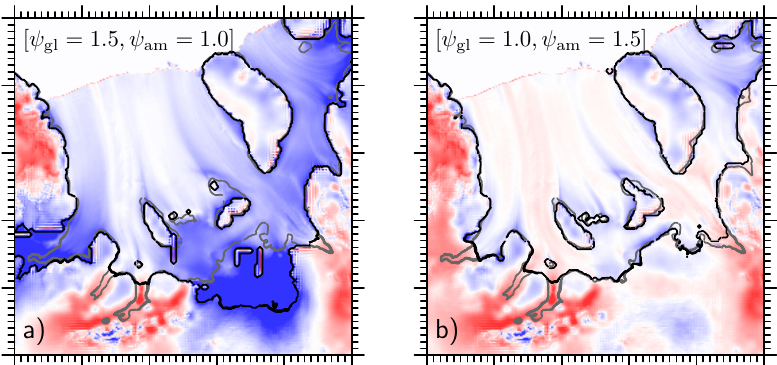
Figure 9. Grounding line location and ice thickness change over 2000-year model runs with enhanced sub-shelf accumulation/melt only (a) near to the grounding line and (b) away from the grounding